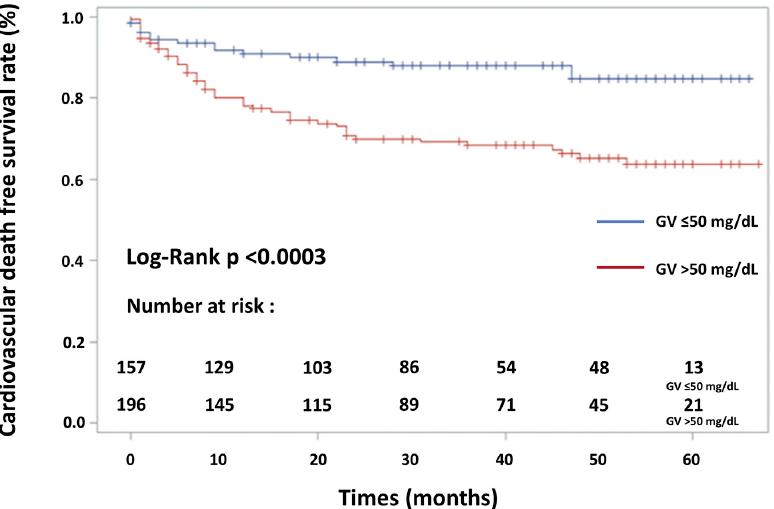
Figure 3. Kaplan–Meier cardiovascular death-free survival curves for the patients in two groups according to glycaemic variability (GV). Pairwise comparisons between patient groups are given. Survival rate was significantly lower in patients with high GV (log-rank test, p < 0.0003—solid blue line: GV ≤ 50 mg/dL; solid red line: GV > 50 mg/dL).